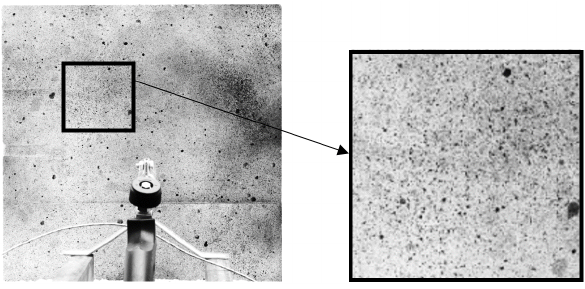
Figure 4. Test stand used for the simple flame test.